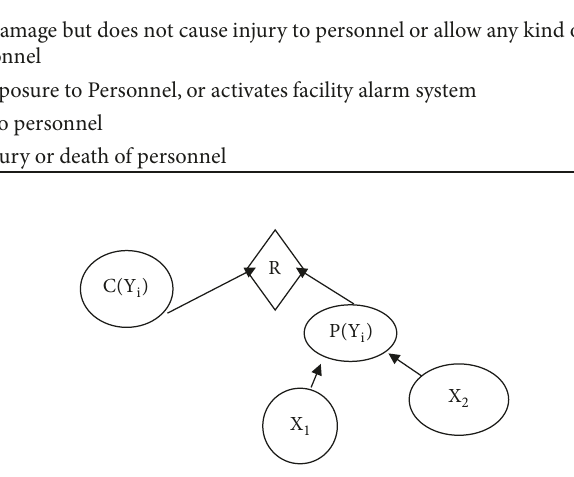
Figure 2: Extension of the Bayes net for the risk